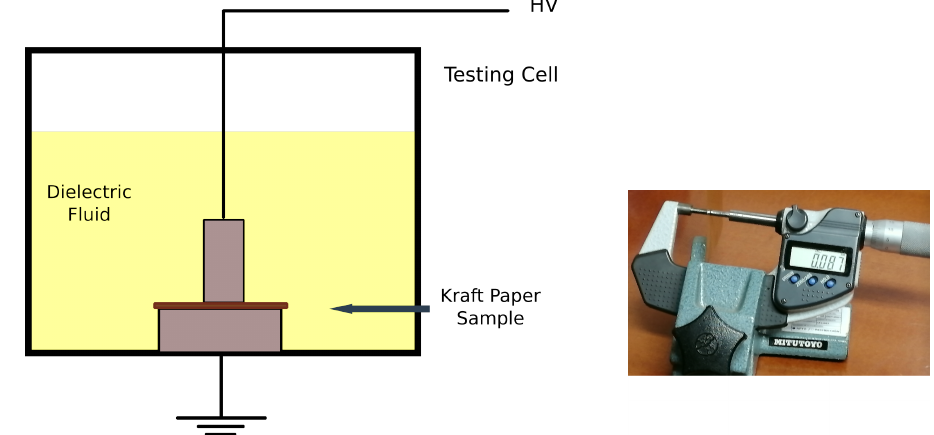
Figure 5. Test cell with Kraft paper specimens surrounded by oil. Thickness